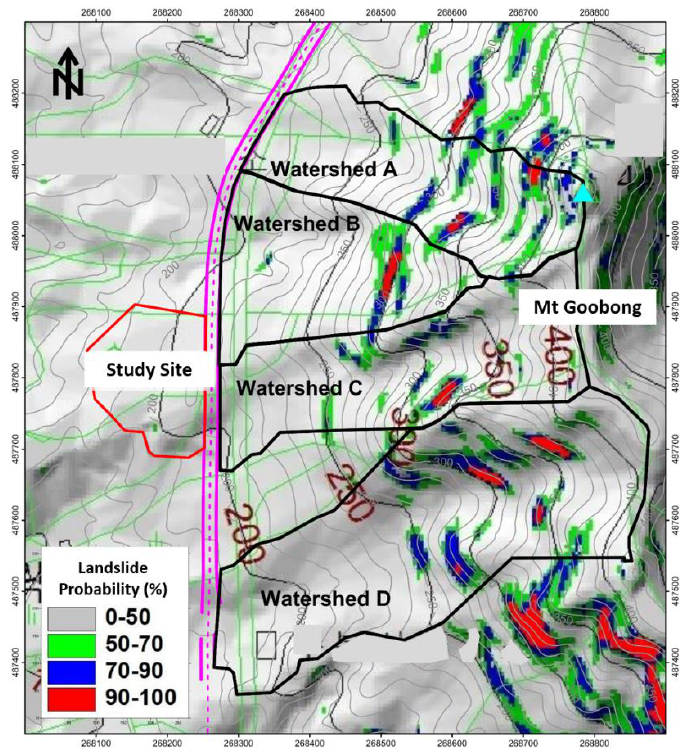
Figure 8. Distribution of watersheds in the simulation area overlain on the landslide prediction map.